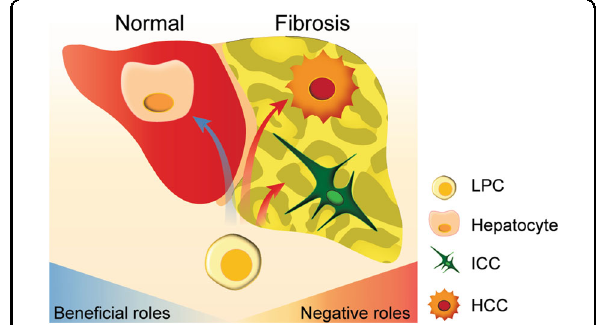
Fig. 3 The bene fi cial and negative roles of LPCs. LPCs play a bene fi cial role in liver regeneration/recovery by differentiating themselves into hepatocytes, whereas they play negative roles by contributing to liver fi brosis and tumor formation, such as HCC and